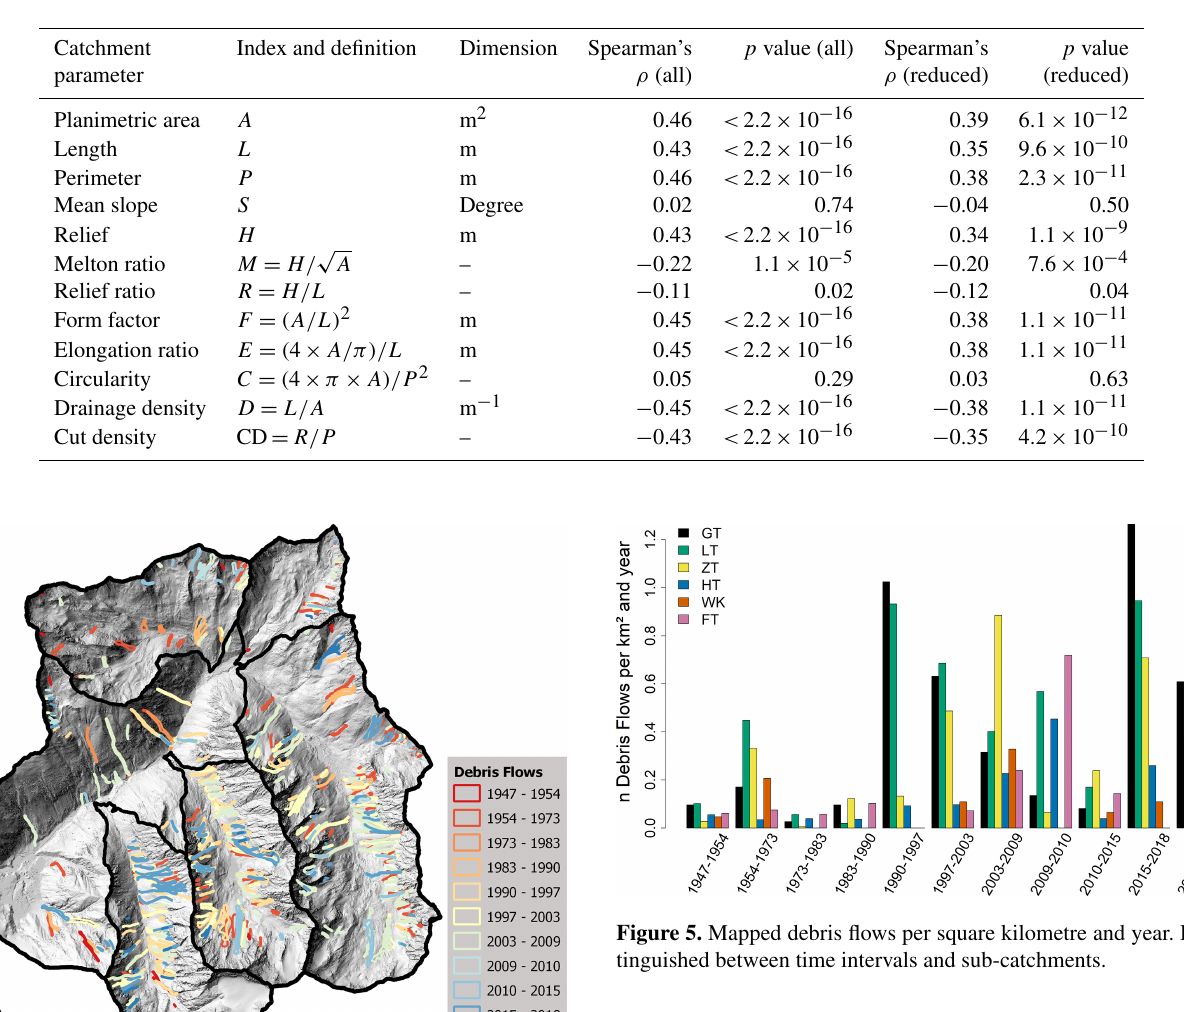
Table 3. Calculated parameters of the hydrological catchments of the slope-type debris flows alongside their definitions and dimensions. Correlation of each parameter with the respective debris flow volumes were calculated by Spearman’s ρ . The p values represent the sig- nificance of the correlations. The statistical parameters are shown for the complete dataset (all; n = 404), as well as for the reduced dataset (reduced; n = 296).